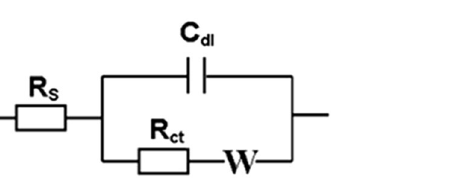
Figure 7. Randles equivalent circuit model used for fitting the measured impedance data and subsequently to determine the kinetic